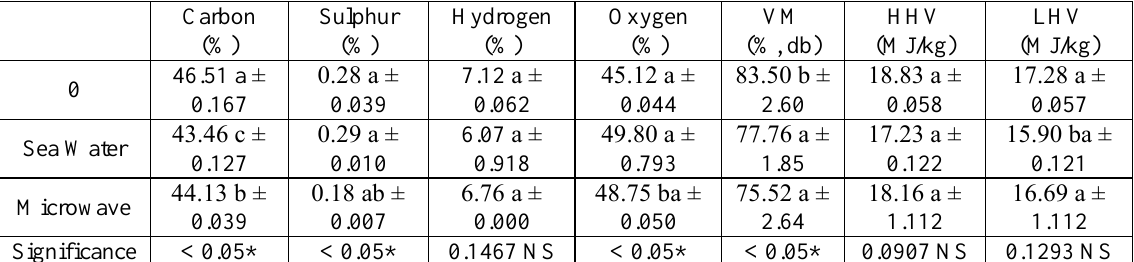
Table 3. Combustible matter content with higher and lower heating values in the SJL residues after fibre extraction